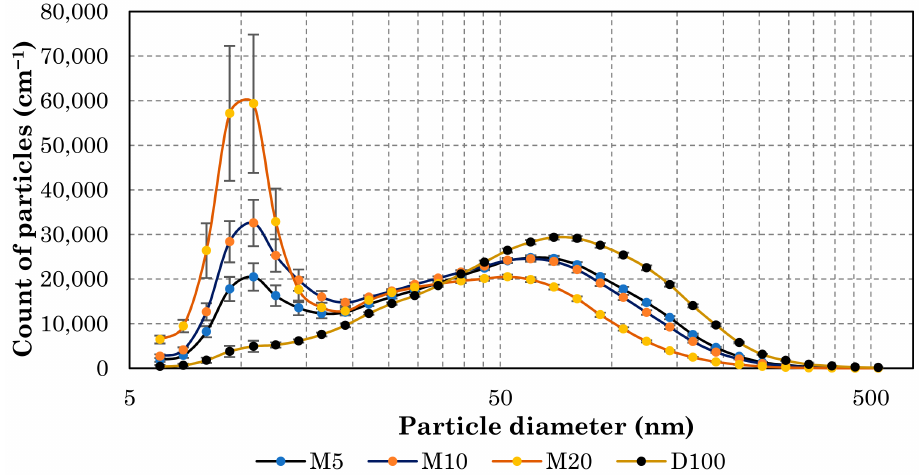
Figure 19. Size distribution of the soot particles in size range 5.6–560 nm at measurement point 3 for all test fuels (error bars represent the standard